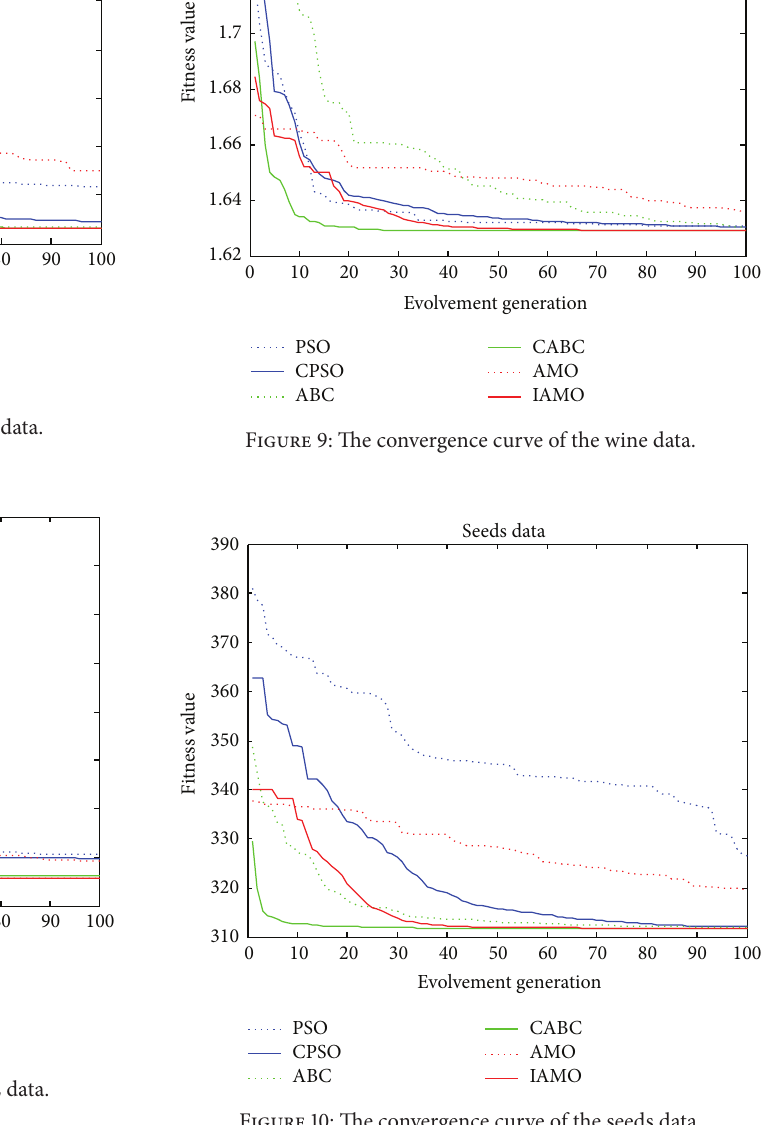
Figure 10: The convergence curve of the seeds